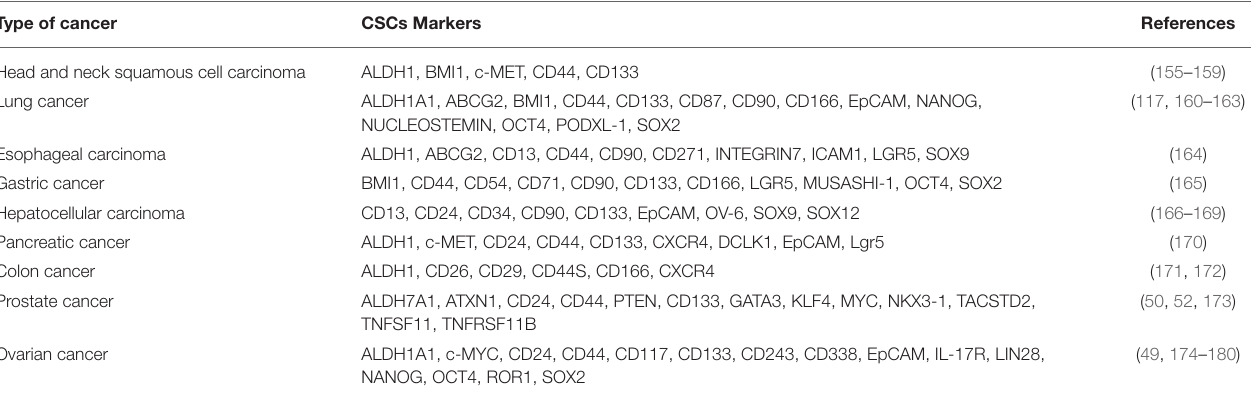
TABLE 1 | CSCs markers in other solid tumors. Type of cancer CSCs